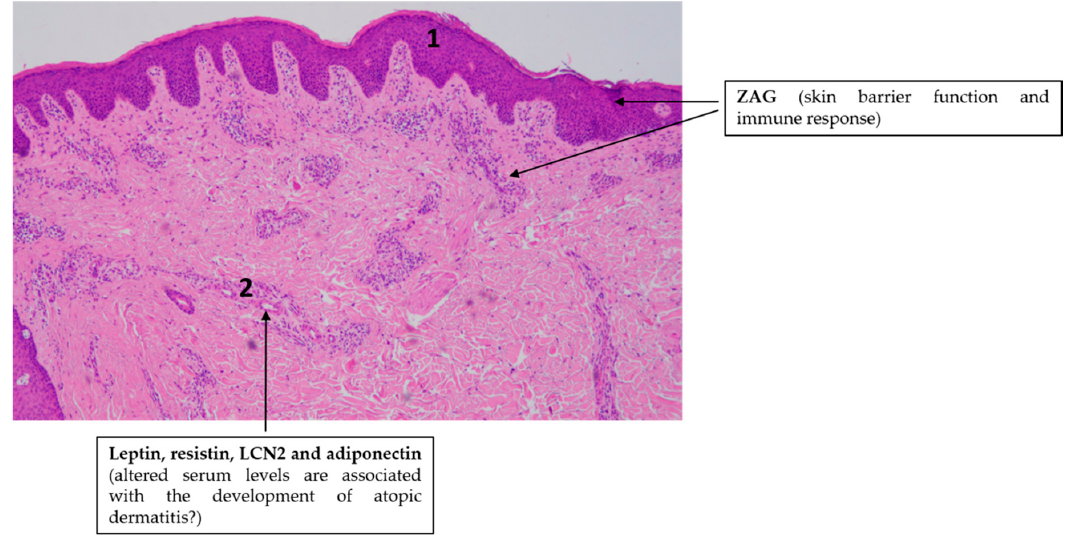
Figure 3. Adipokines might be involved in the pathogenesis of atopic dermatitis. Note the simplified characteristic histopathological findings in AD skin: slight epidermal hyperplasia with impaired barrier function (1) and immune cell infiltration in the dermis (2). Hematoxylin eosin staining; original magnification: 50×.